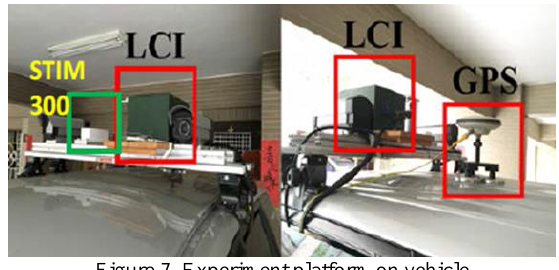
Figure 7. Experiment platform on